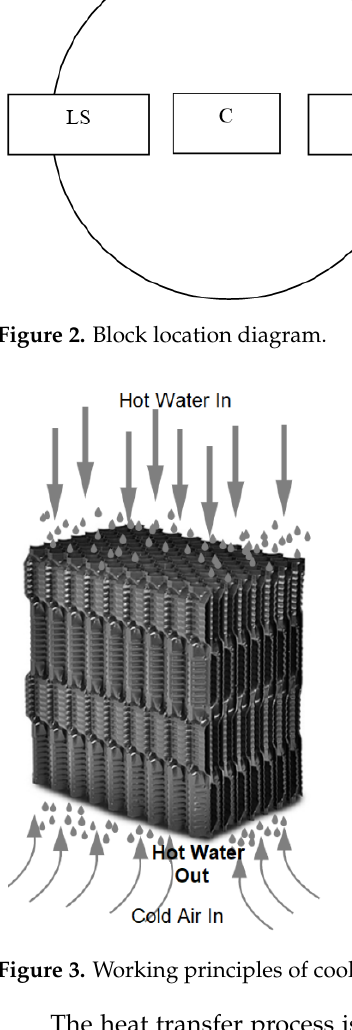
Figure 2. Block location diagram.